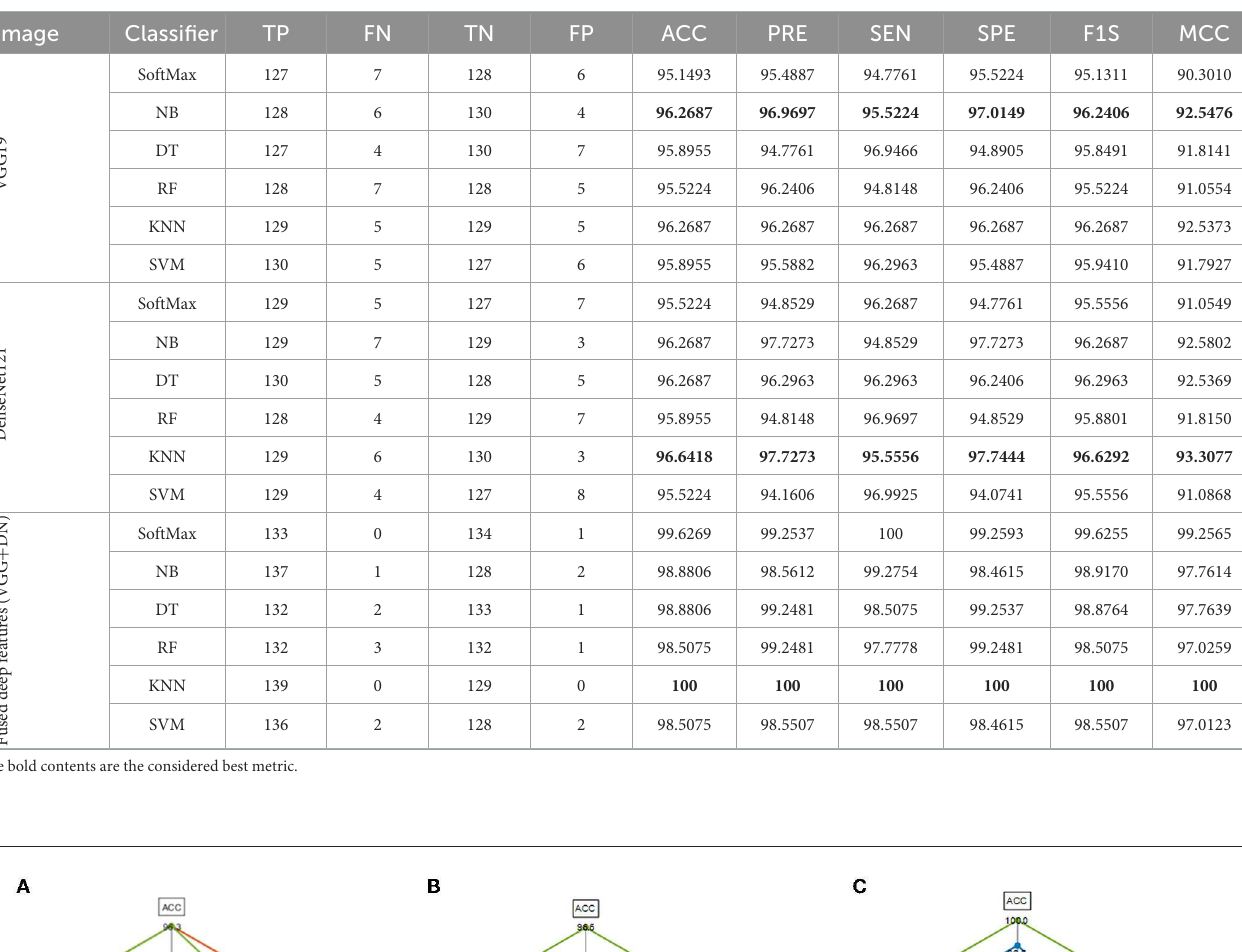
TABLE 6 Overall results achieved with the proposed framework for individual and fused features.